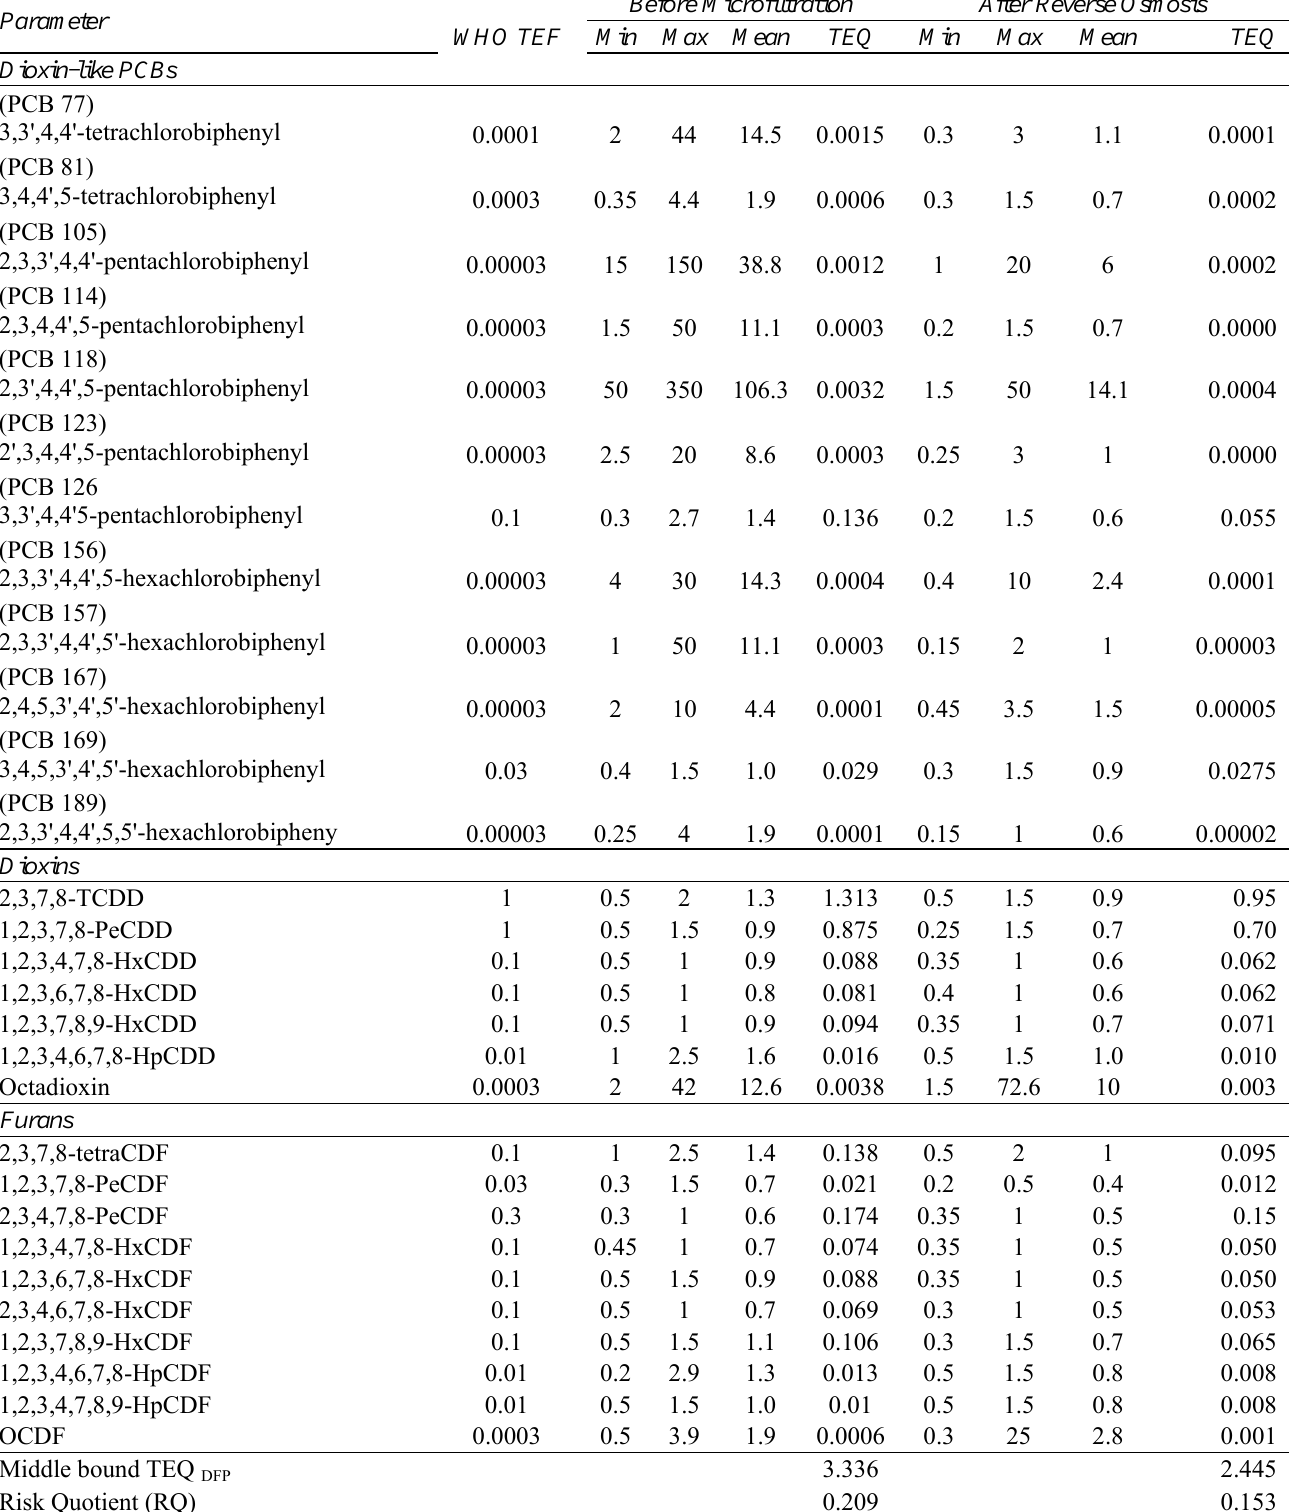
Table 5: Minimum, maximum, and mean of the pooled composite samples before MF and after RO in pg/L and percent contribution to total TEQ (middle bound) using the mean concentration Before Microfiltration After Reverse Osmosis Parameter Min Max Mean WHO TEF